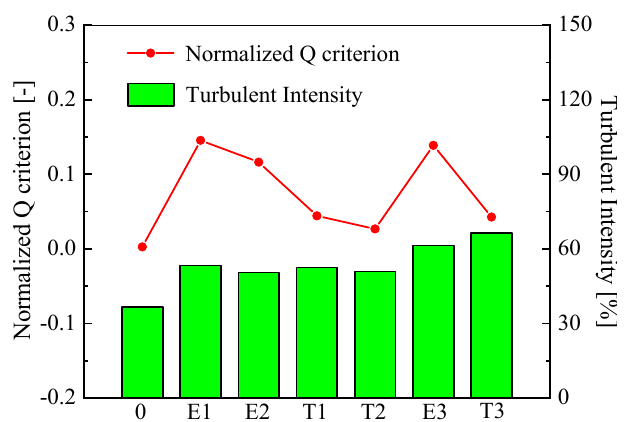
Figure 4. The Q and turbulence intensity in different flow fields.